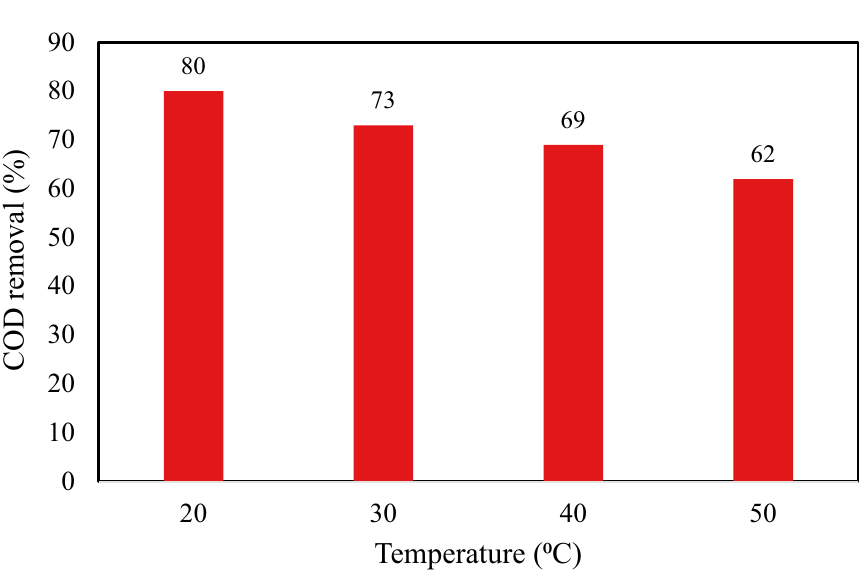
Figure 6. Effect of temperature on the COD reduction efficiency using TiO 2 –chitosan